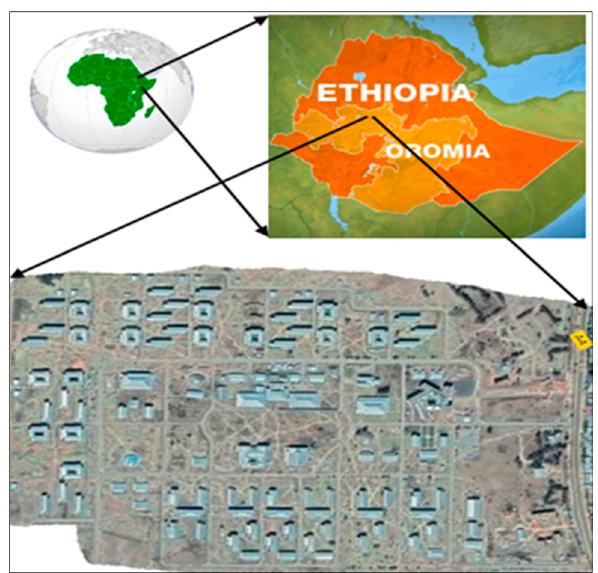
Figure 1. Location of study site Ambo City (Oromia regional state, West Shoa zone, Ethiopia, East Africa).